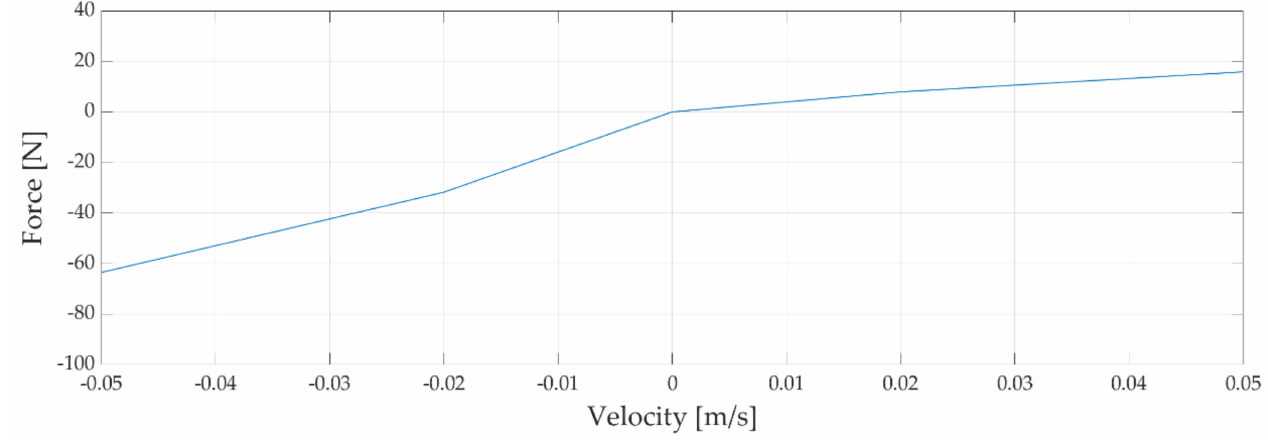
Figure A2. Baseline model rear damper Force/Velocity graph.